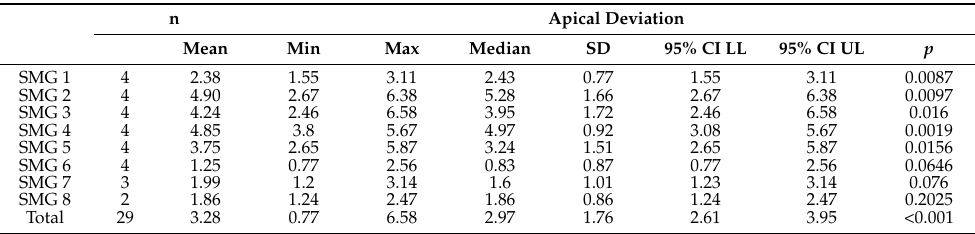
Table 1. Statistic summary of the deviation between the planned and the actual paths for each of the 3D-printed surgical metal guides. n Apical